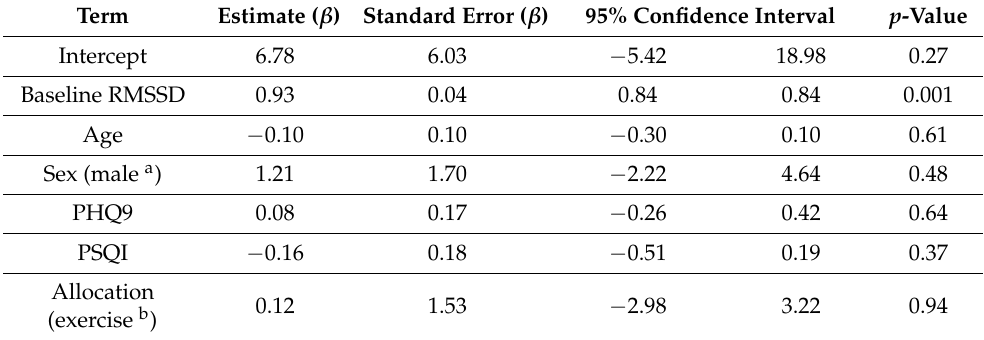
Table 2. ANCOVA table for intent-to-treat analysis of RMSSD during sleep period at